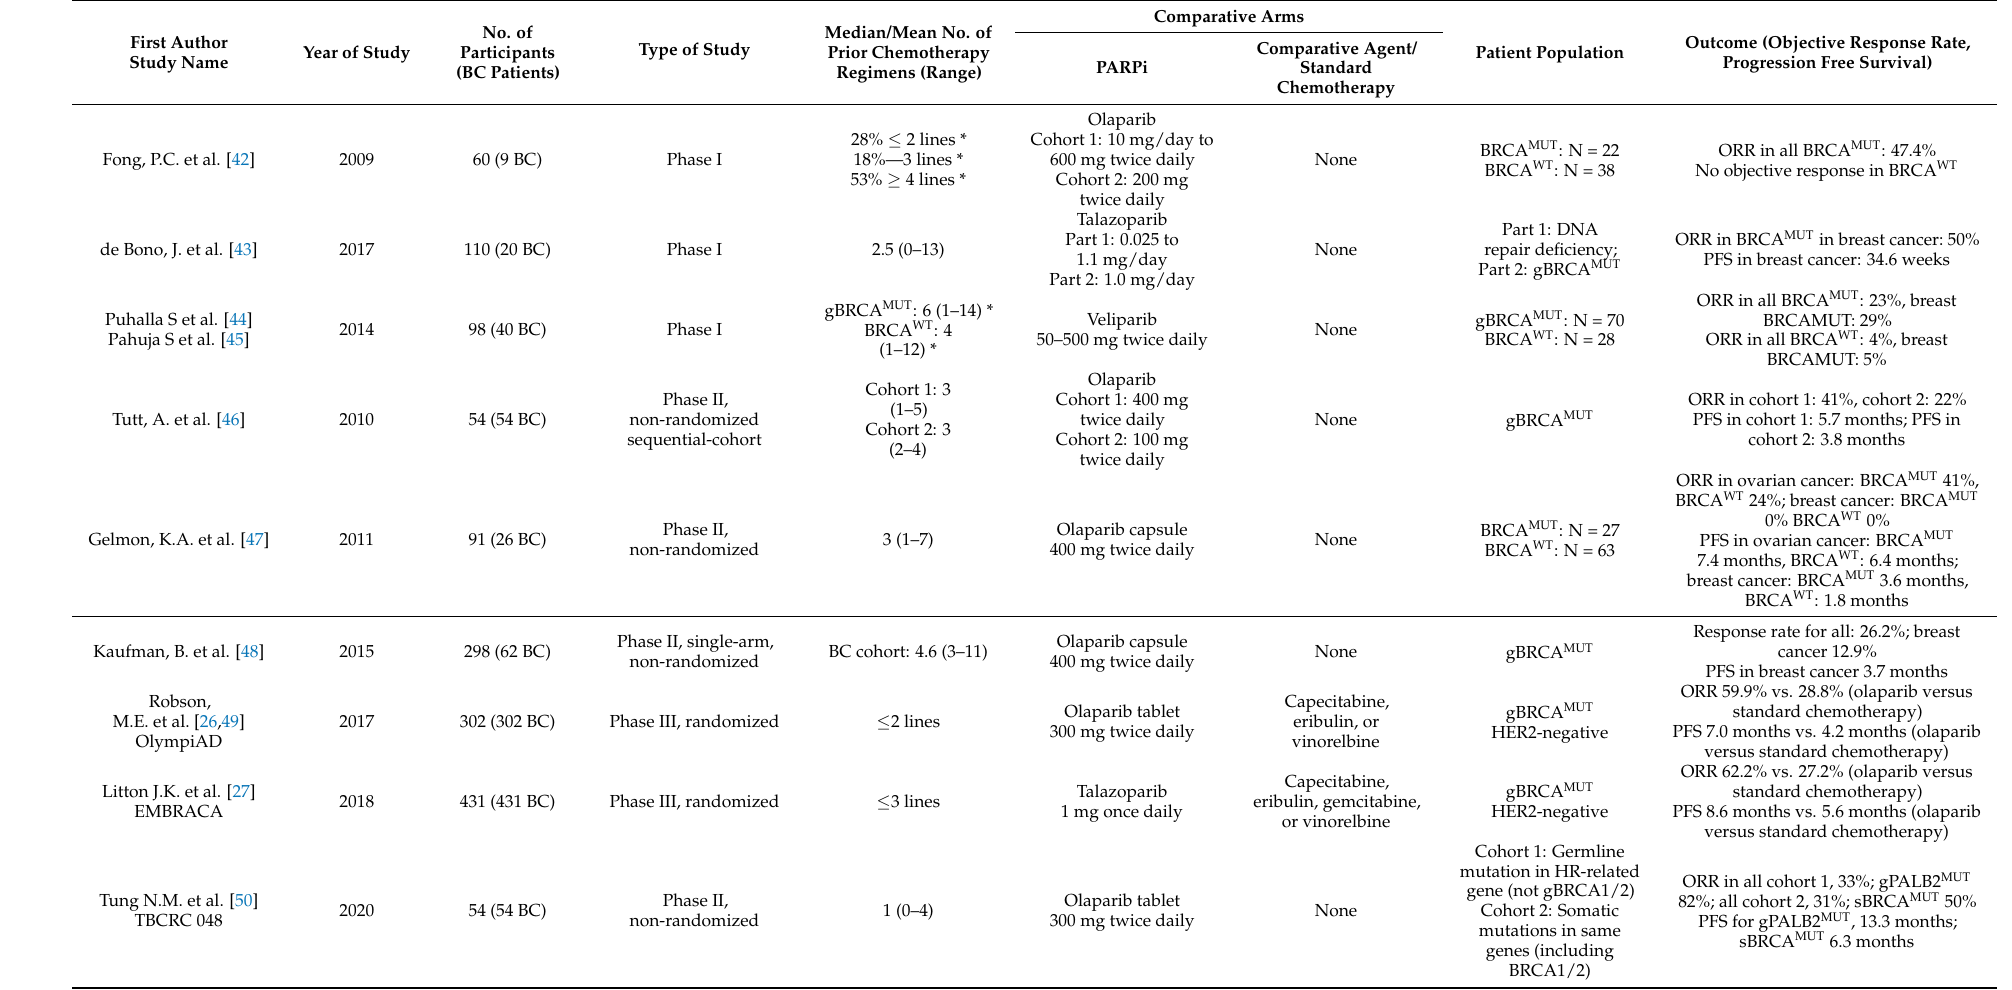
Abbreviations: BC, breast cancer. * Previous treatment